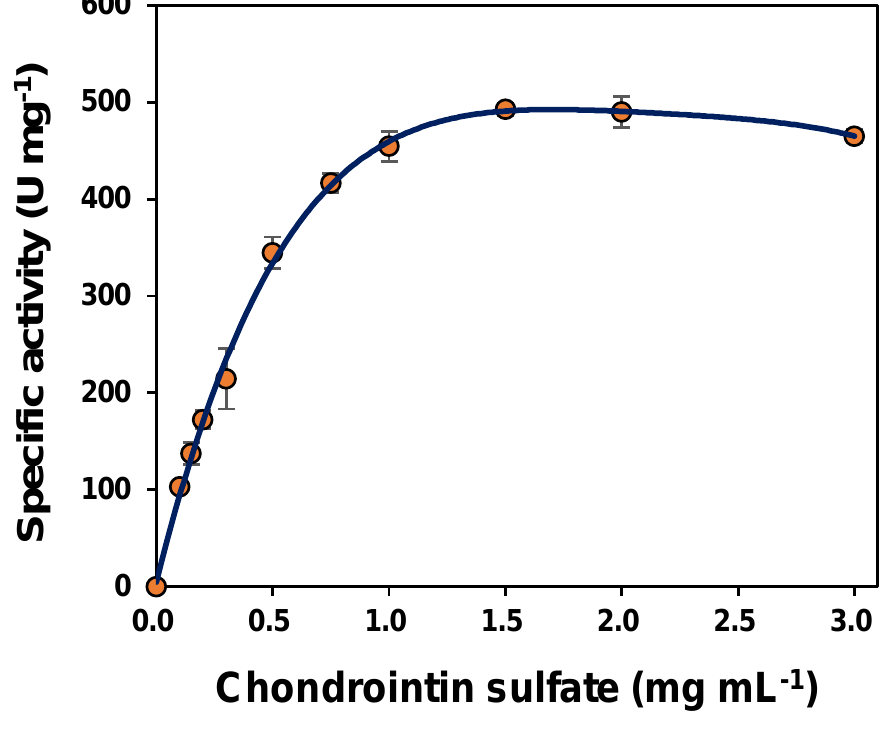
Figure 4. The effect of chondroitin sulfate concentration on the activity of the Chon-ABC at 37 °C in 75 mM pH 8.0 PBS.